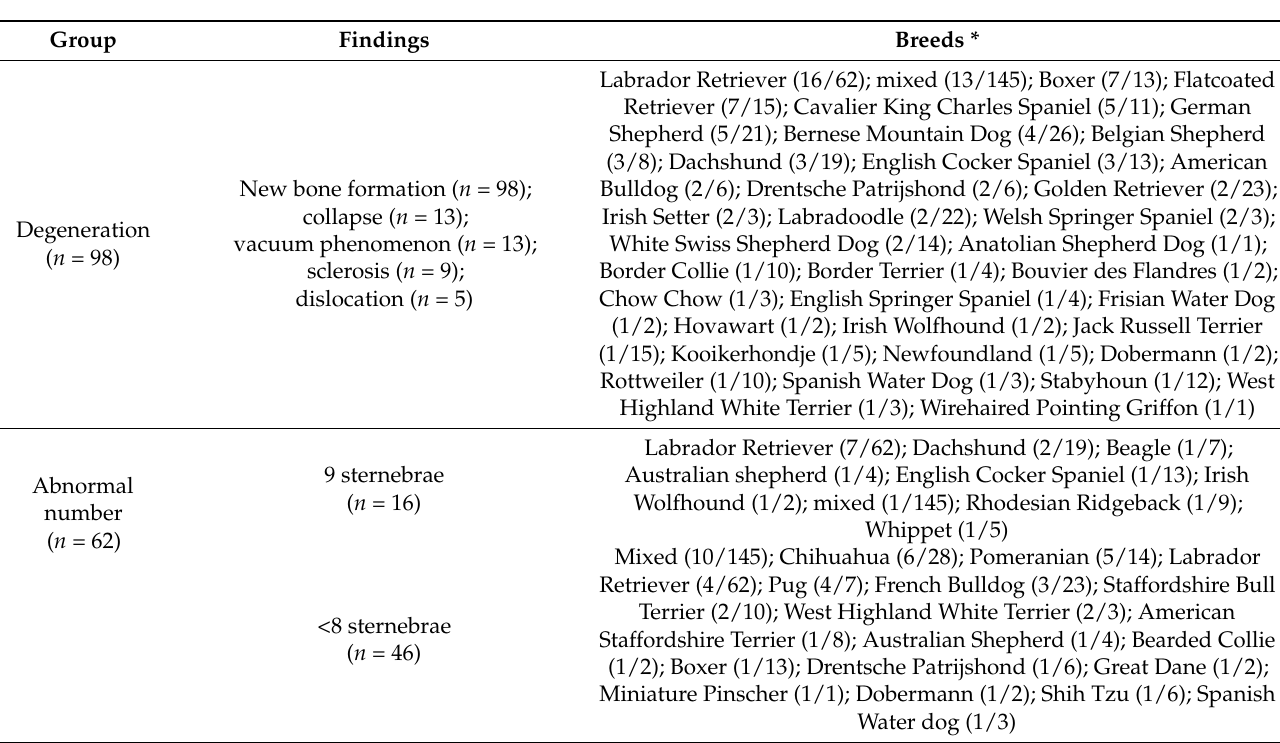
Table 1. Radiographic findings and breeds per category of sternal abnormality in dogs.